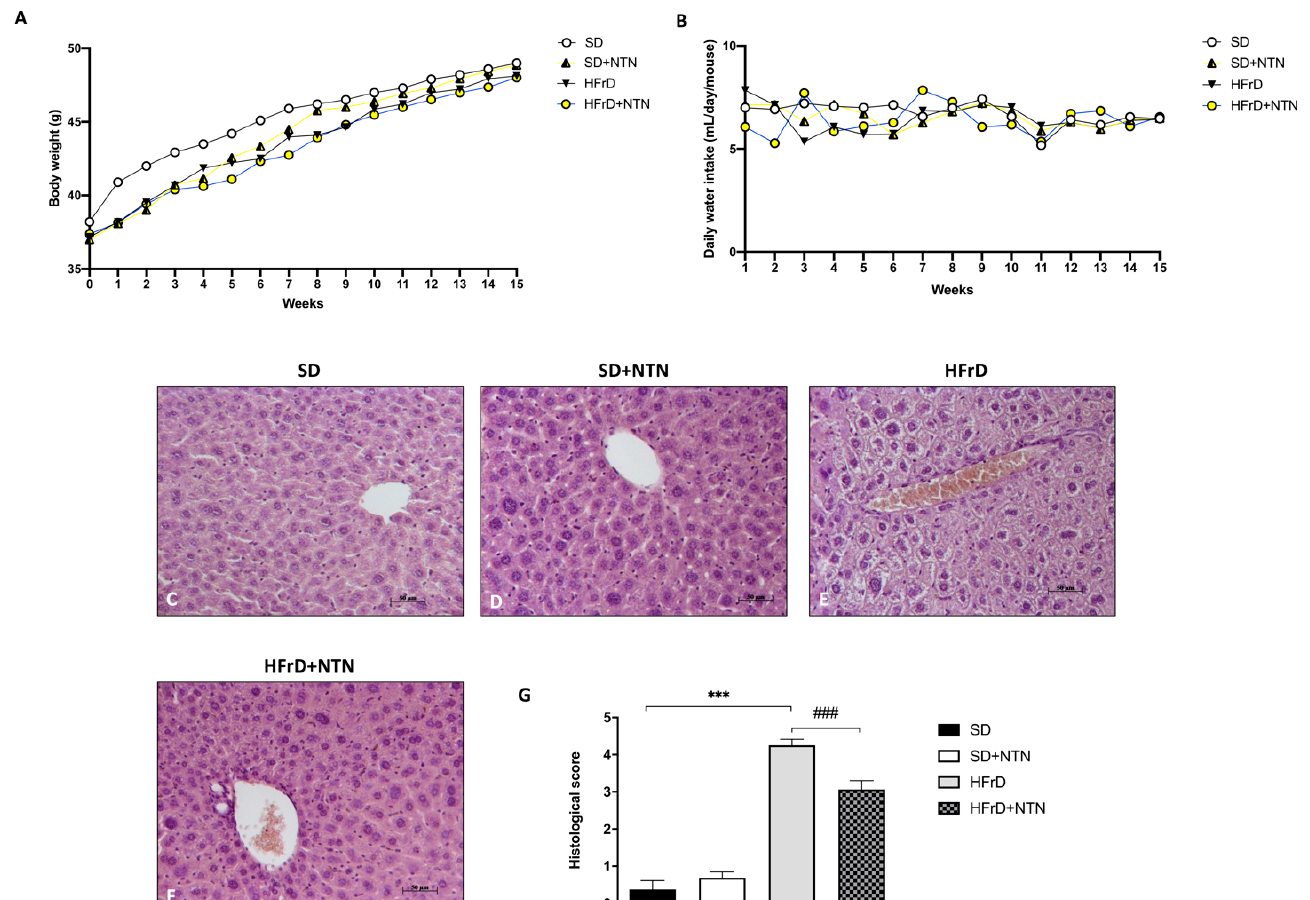
Figure 9. Effects of NTN on liver damage in HFrD. No considerable variations were detected in body weight and food intake in HFrD mice ( A , B ). Significant macrovesicular and microvesicular steatosis was observed in mice fed with HFrD ( E , G ) compared to SD and SD + NTN mice ( C , D , G ). The administration of NTN was able to significantly counteract the extent of liver damage in HFrD mice ( F , G ). Data are representative of at least three independent experiments. Values are means ± SEM. One-Way ANOVA test. *** p < 0.001 vs. SD; ### p < 0.001 vs. HFrD.